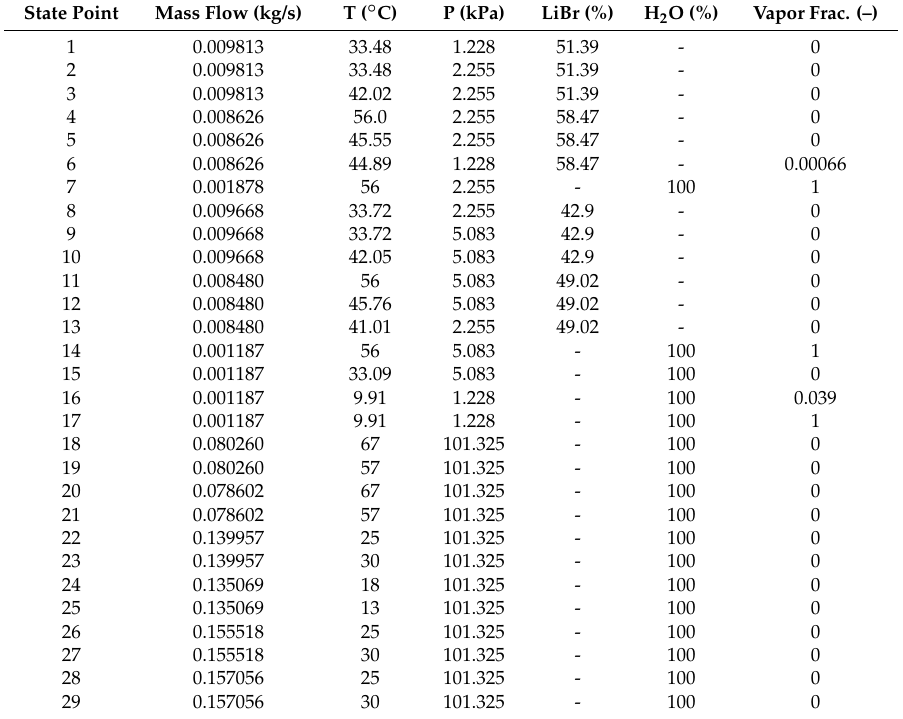
Table 5. The state point results calculated for the half-effect absorption chiller system that operates at